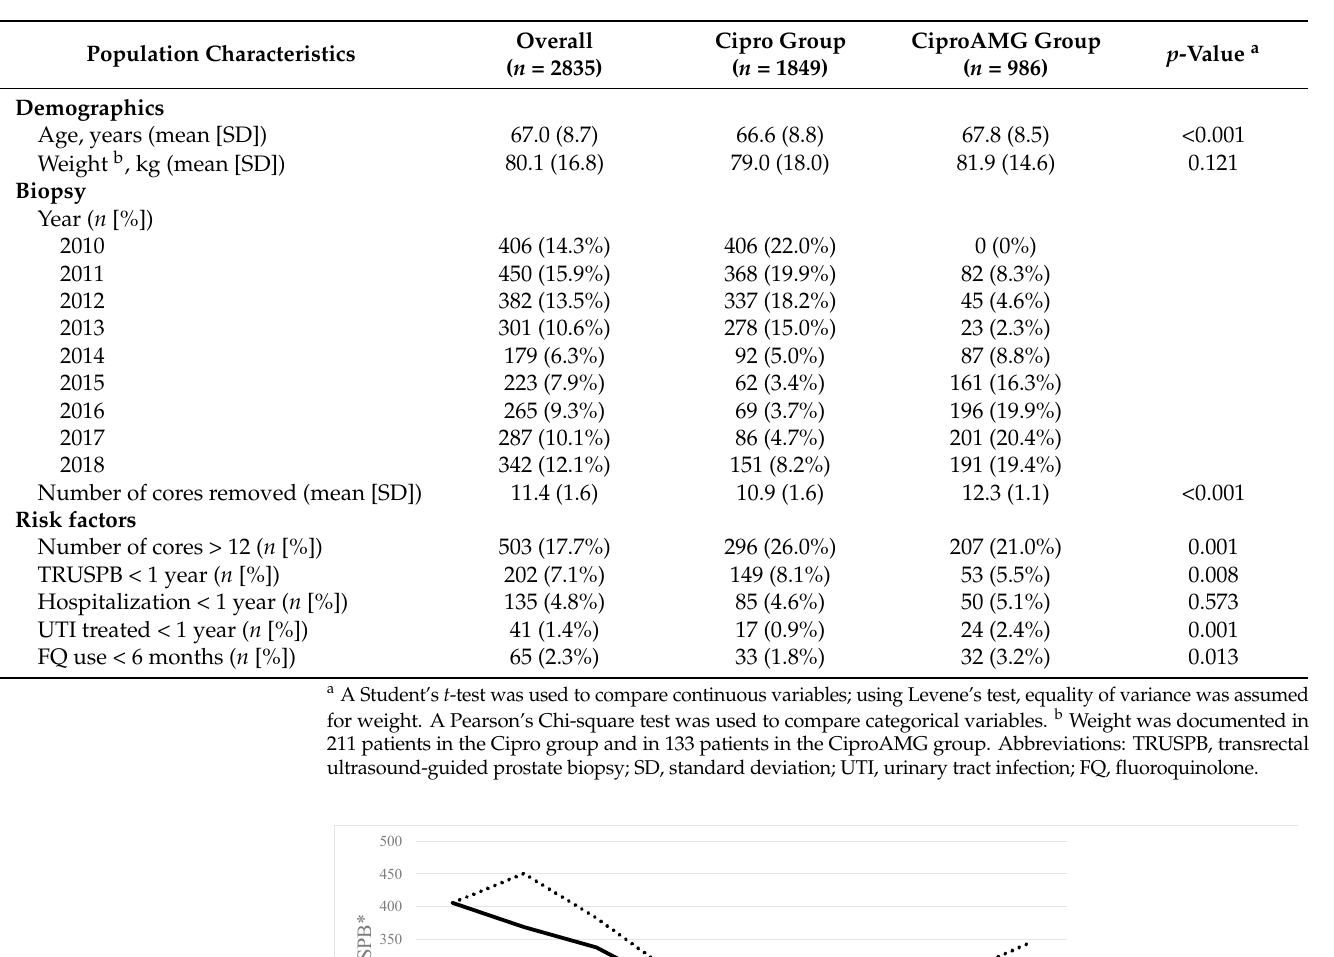
Table 1. Patients’ characteristics stratified by treatment group.